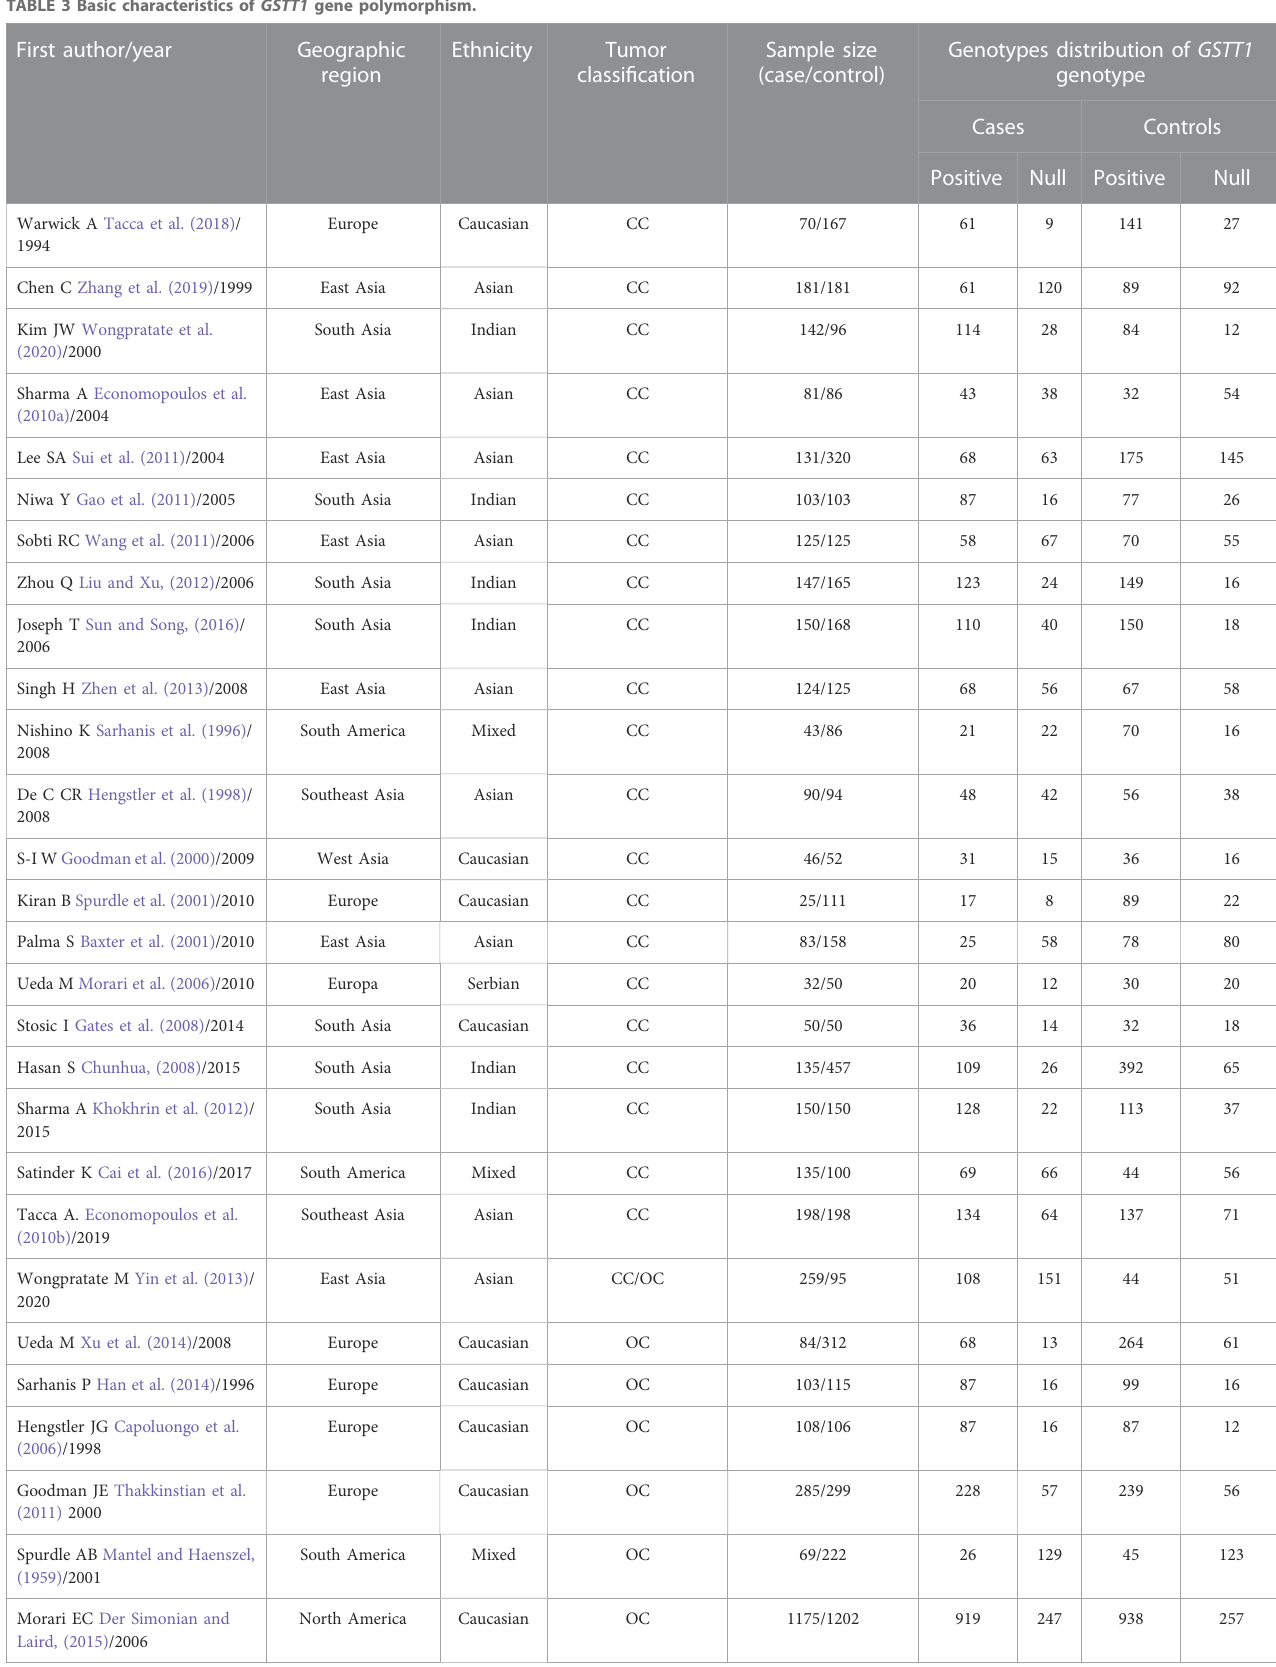
TABLE 3 Basic characteristics of GSTT1 gene